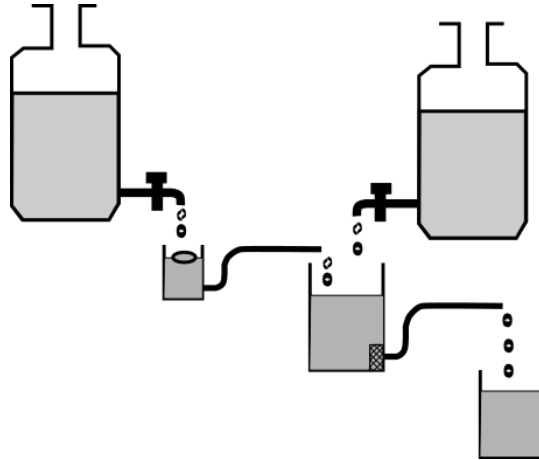
Figure 8. Schematic of the multicompartment dissolution apparatus. Adapted from Reference [55].